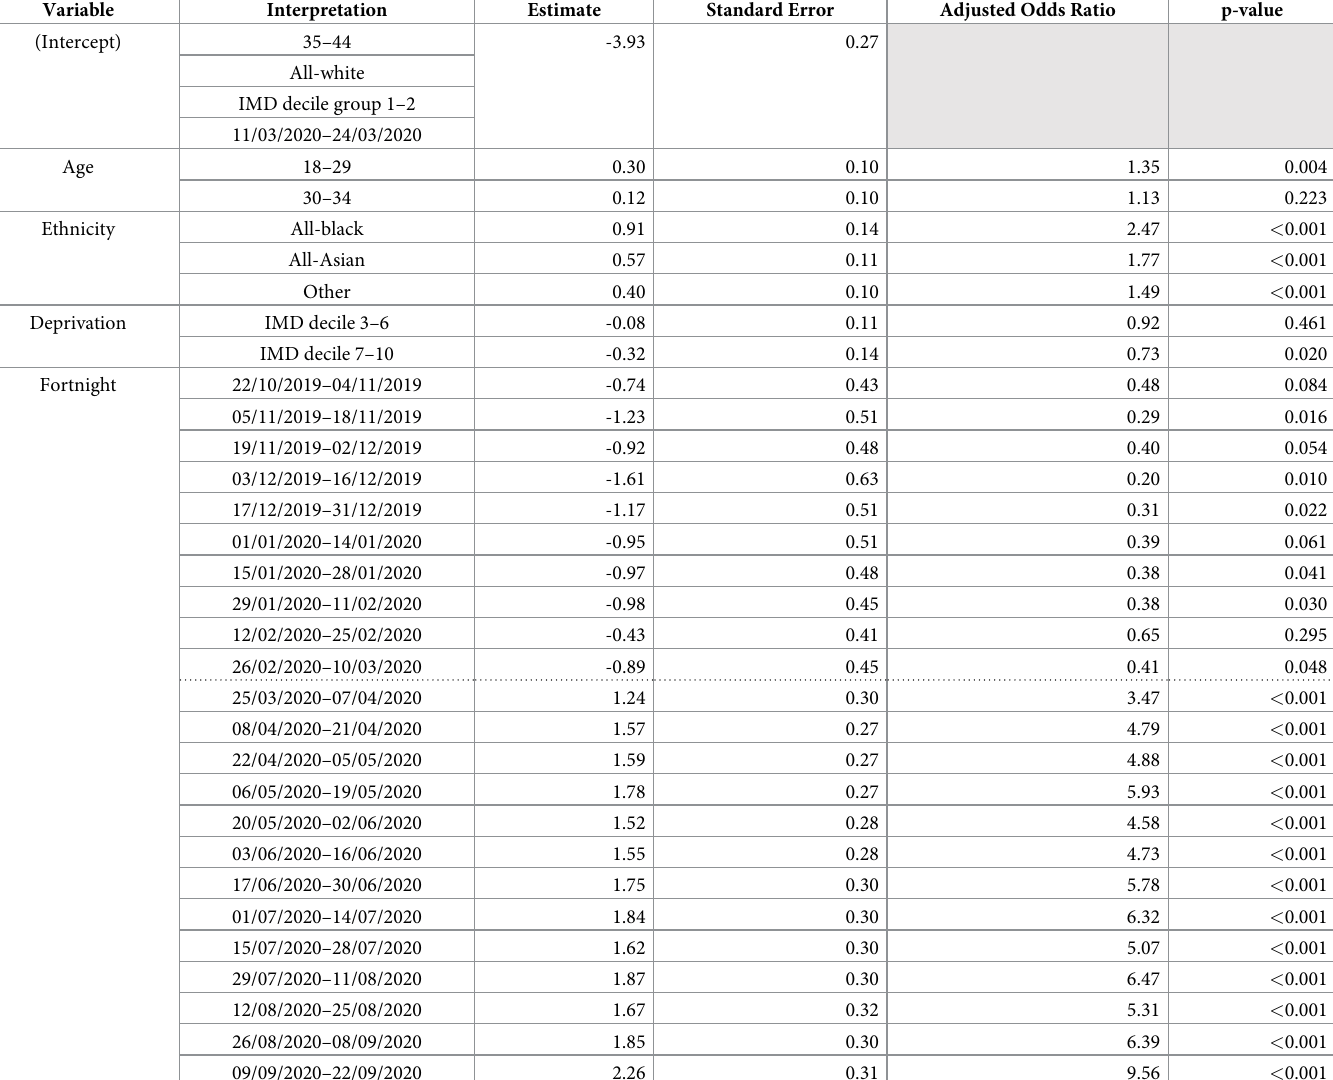
Table 3. Results of logistic regression for seroreactivity using demographic variables. Coefficient estimates, standard errors and p-values for the logistic regression model with age group, ethnicity, IMD and fortnight of sample (across the primary study period October 2019 –September 2020) as predictors of seroreactivity. The dotted line indicates the timing of the reference